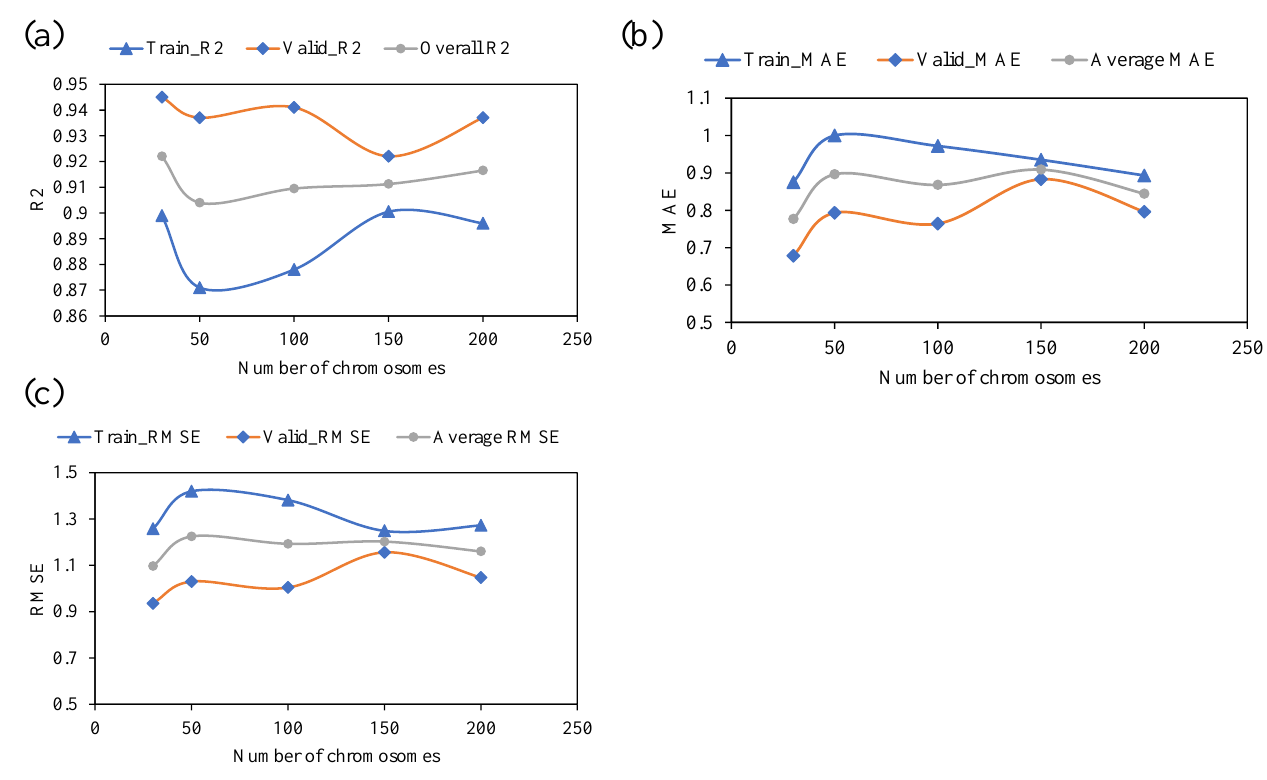
Figure 5. Effect of the number of chromosomes on the performance of the models: ( a ) R 2 , ( b ) MAE, and ( c ) RMSE.